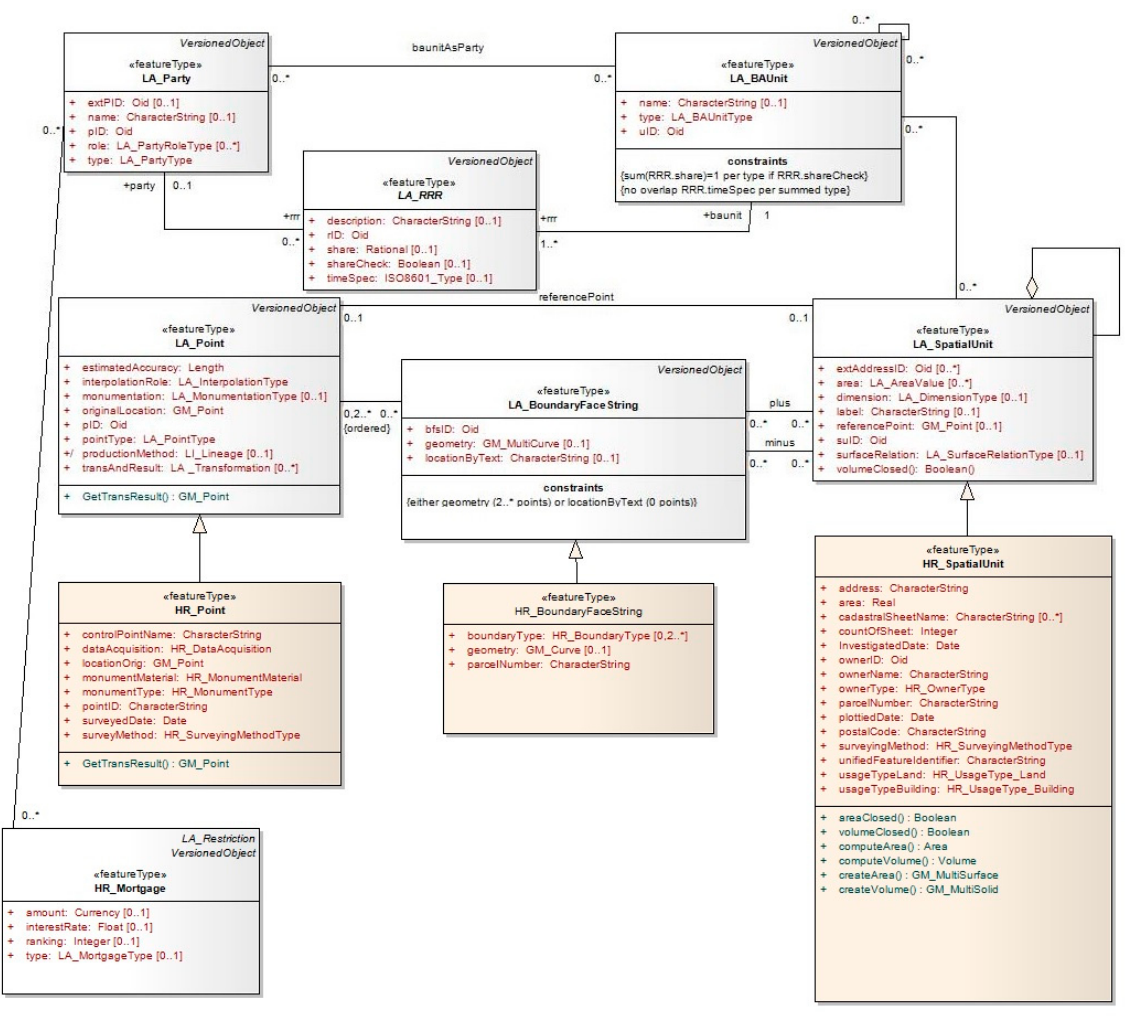
Figure 2. Croatian country profile LADM diagram [19].